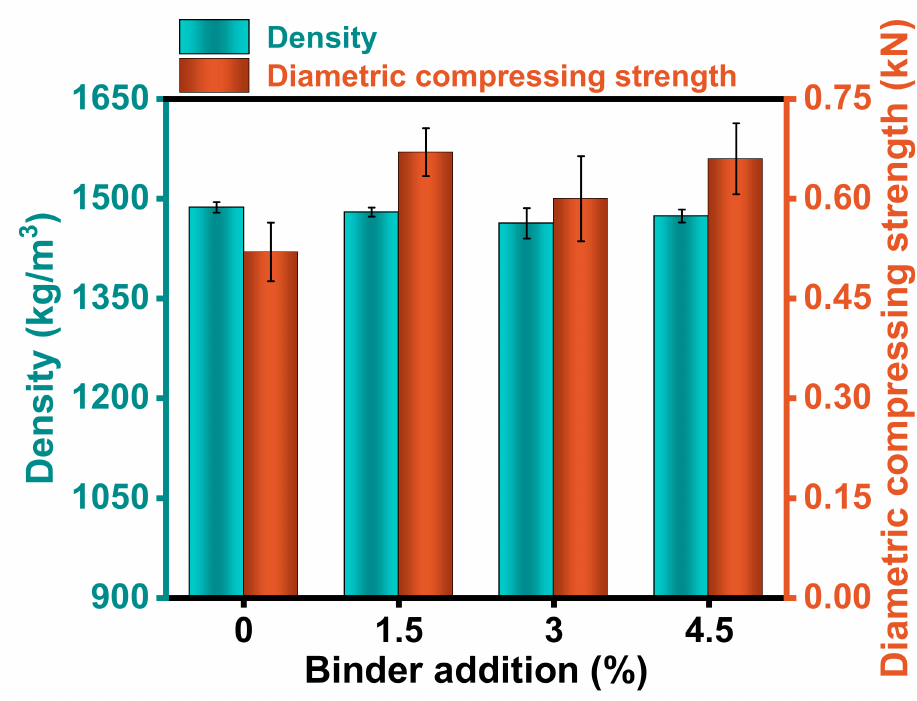
Figure 4. Effect of PS binder on the density and diametric compressing